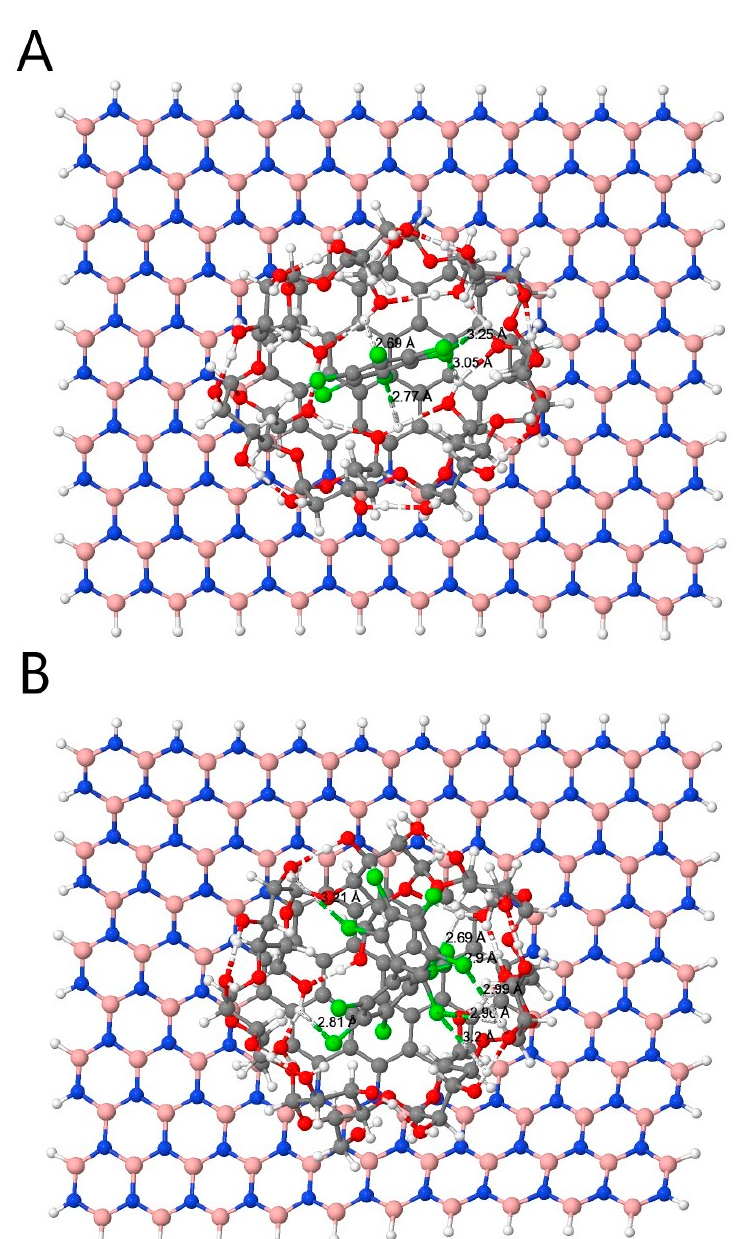
Figure 2. Equilibrium structures of ( A ) hexachlorobenzene (cb) and ( B ) decachlorobiphenyl (pcb) adsorbed on carbon-doped hexagonal boron nitride (h-BN-CC2) decorated with beta-cyclodextrin (BCD).